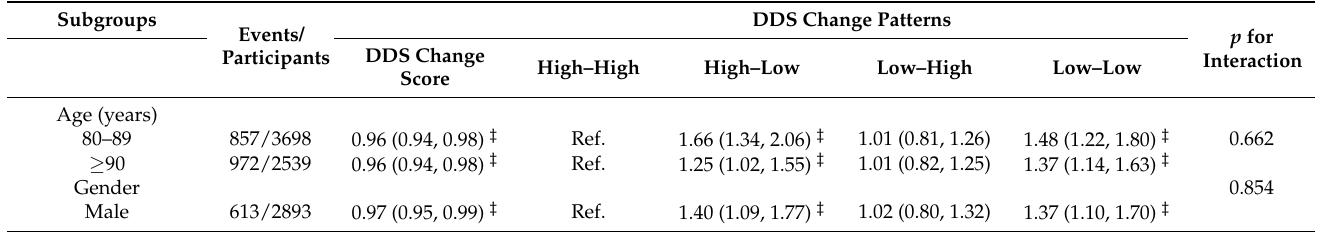
Table 3. The association between the DDS change patterns and risk of cognitive impairment in